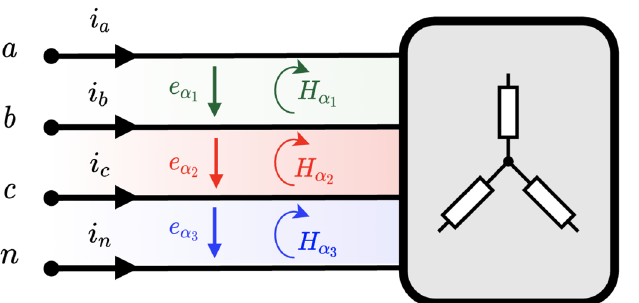
Figure 6. Generic Four-wire three-phase circuit. Three different power channels are formed (green, red and